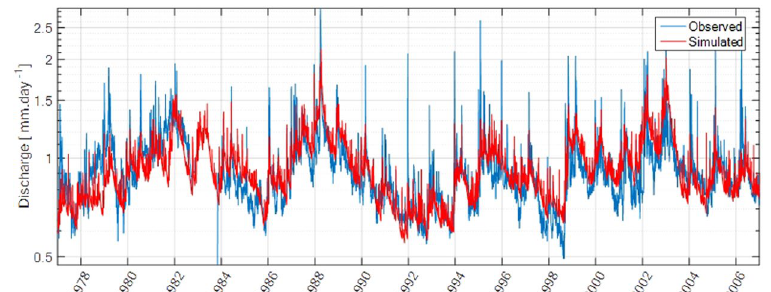
Figure 14. Comparison between observed and modeled discharge over the period of